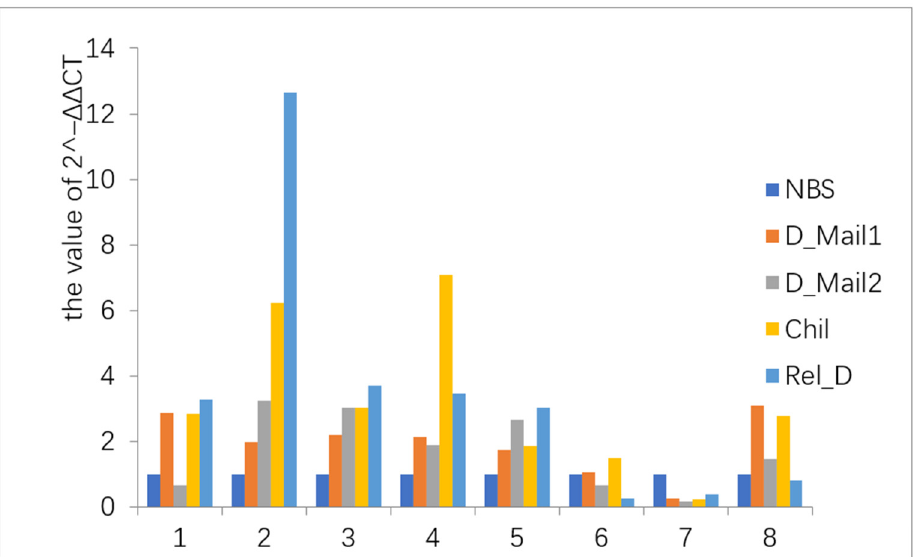
Figure 2. Quantitative reverse transcription RT-PCR analysis. The horizontal coordinates indicate the eight randomly selected genes (Supplementary Table S1). The vertical coordinate indicates the value of 2ˆ − ∆∆ Ct . The expression trends of these eight genes in the five phases were the same as the transcriptome, indicating the data are true and reliable. Gene expression levels in the NBS phase were set to 1, whereas gene expression levels in other phases were considered as upregulated for values of more than 1 and downregulated for values of less than